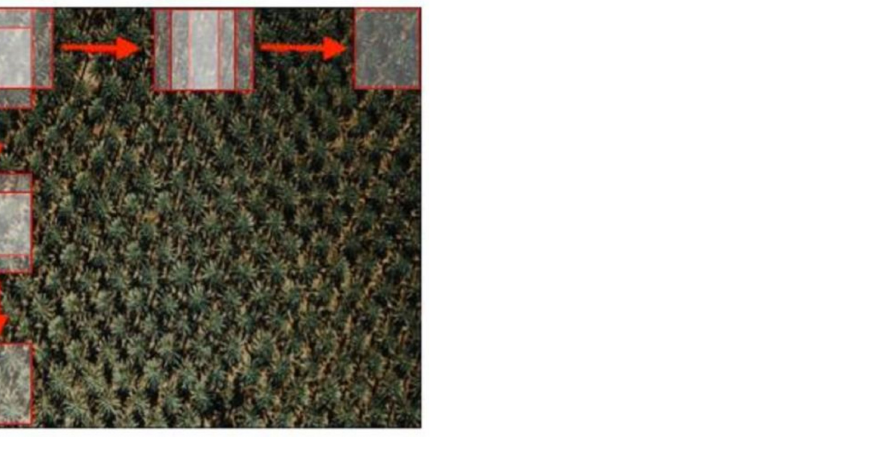
Figure 3. Label prediction using sliding window technique (Red squares represent sliding window).